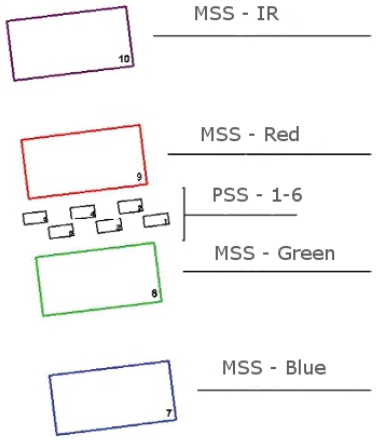
on figure 5. Span width for PSS sensor (6 CCD matrixes) will be 23.3 km, for MSS sensor (4 CCD matrixes) span width will be 20.1 km